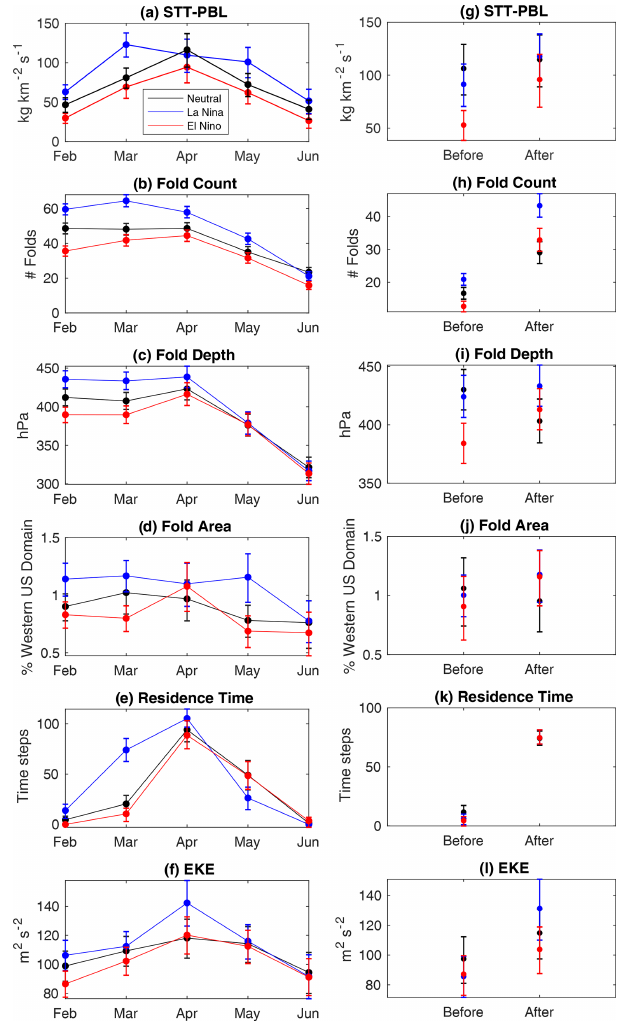
Figure 10. As in Fig. 6 but grouped by El Niño years (red), La Niña years (blue), and ENSO-neutral years